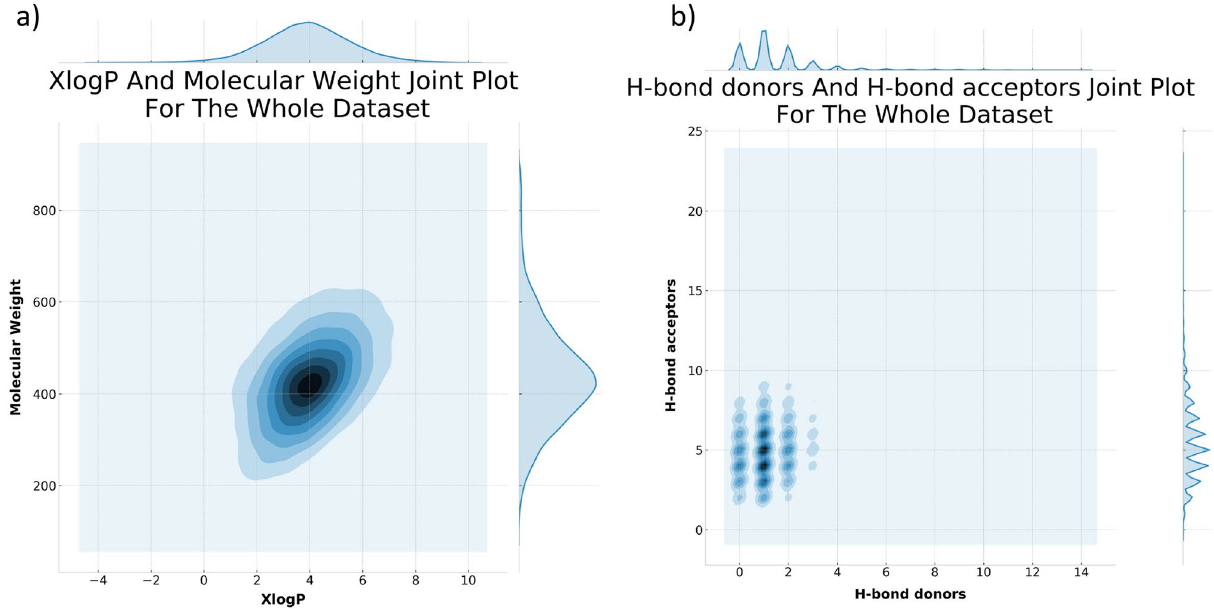
Figure 2. Two joint plots showing the distribution of the selected range of physicochemical properties considered in the current study, ( a ) Molecular weight & XlogP, and ( b ) H-bond acceptors & H-bond donors. The figure was generated with Python Matplotlib 3.2.1: https:// matpl otlib. org/.